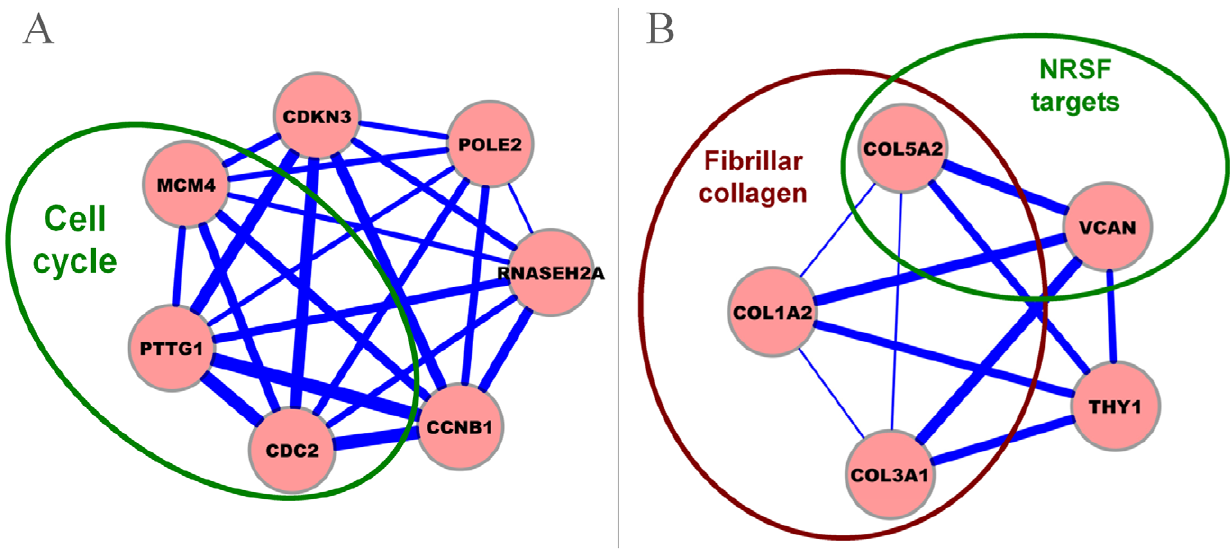
Figure 7. Examples of phenotype-specific modules associated with (A) Glioma and (B) muscle. The width of an edge is proportional to the average correlation of its genes in the datasets where the module occurs.